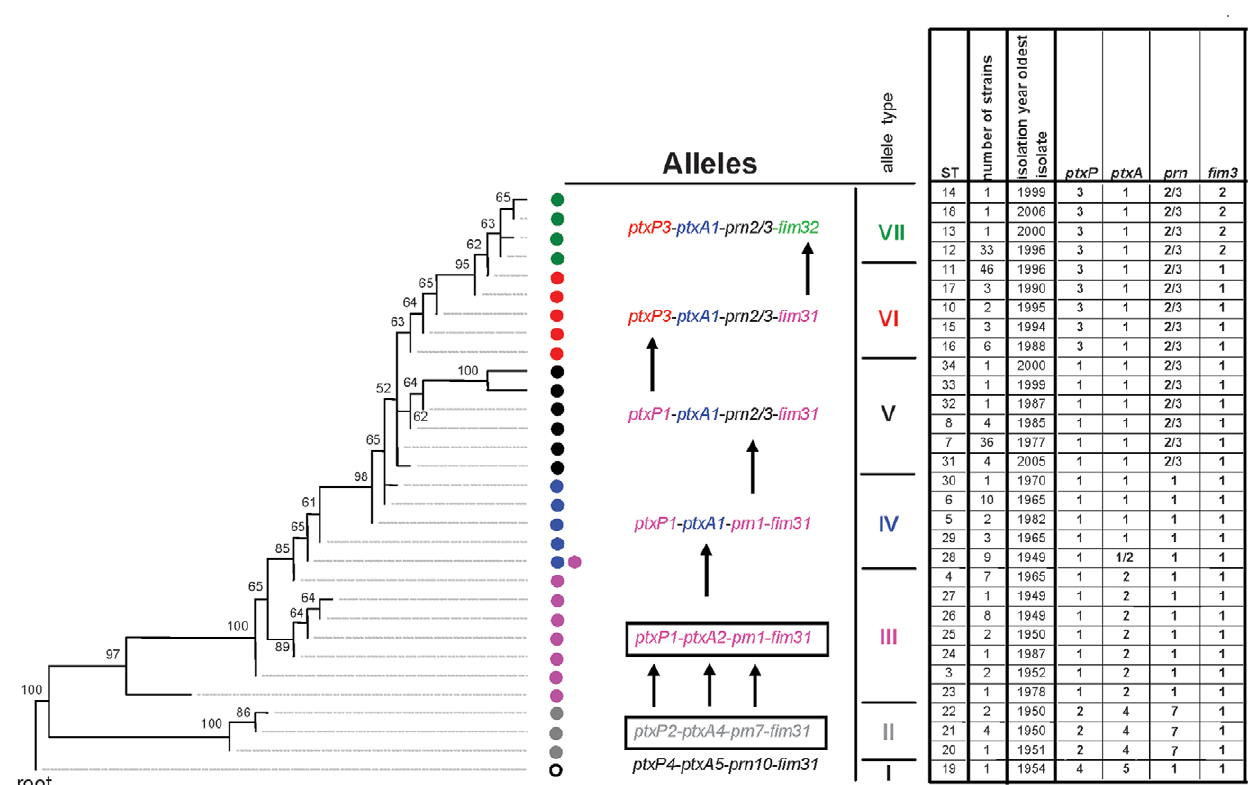
Figure 1. Relationship between phylogeny and the accumulation of mutations in virulence genes. The Maximum Parsimony tree was based on 85 SNPs and 198 Dutch strains isolated between 1949 and 2008. The 85 SNPs resolved the 198 strains in 31 sequence types (STs). Alleles for the pertussis toxin promoter ( ptxP ), the pertussis toxin A subunit ( ptxA ), pertactin ( prn ) and the serotype 3 fimbrial subunit ( fim3 ) are indicated. The alleles prn2 and prn3 were combined as they are both non-vaccine types. Based on the ptxP , ptxA , fim3 and prn alleles, seven allele types (ATs), I–VII, could be distinguished. Coloured dots represent distinct ATs and arrows indicate changes between ATs. ATs used for the production of the whole cell and acellular vaccines are blocked. Bootstrap values are indicated in the tree.